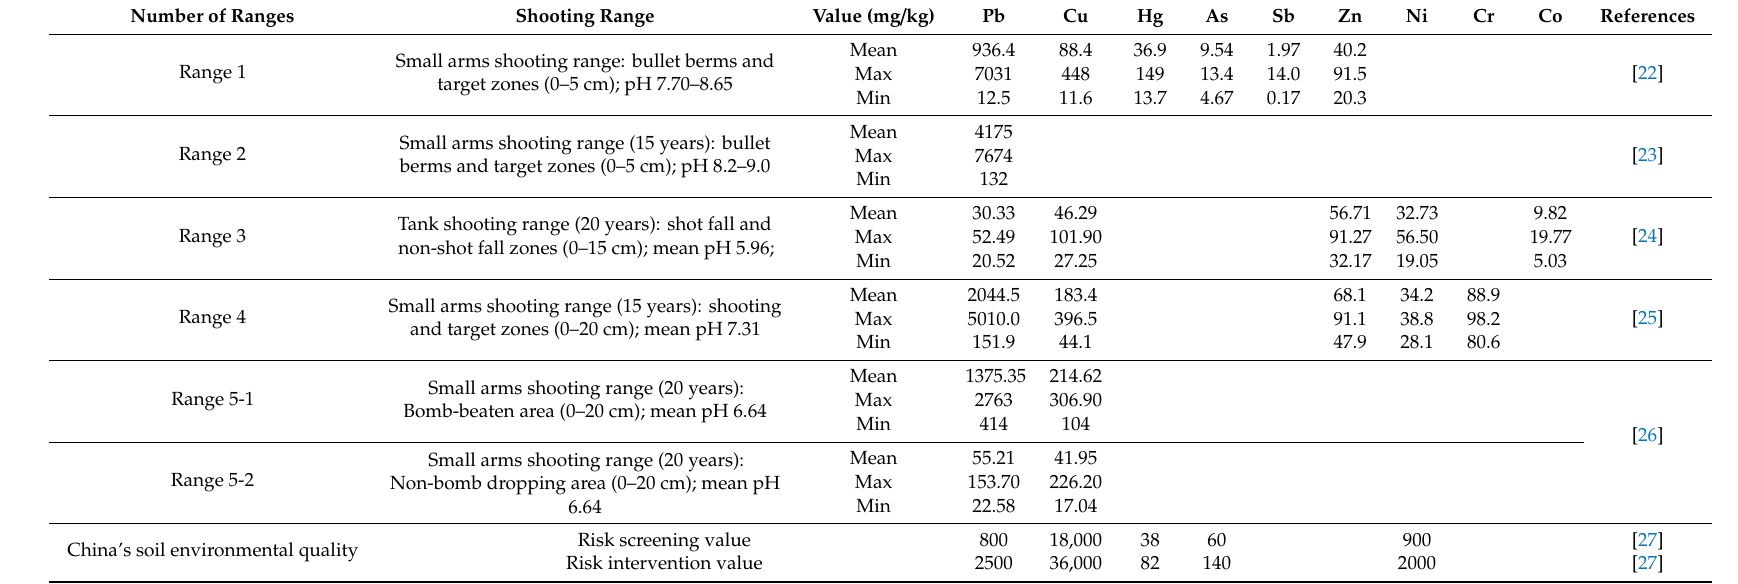
Table 1. Concentrations of various metals in shooting rang soils reported in